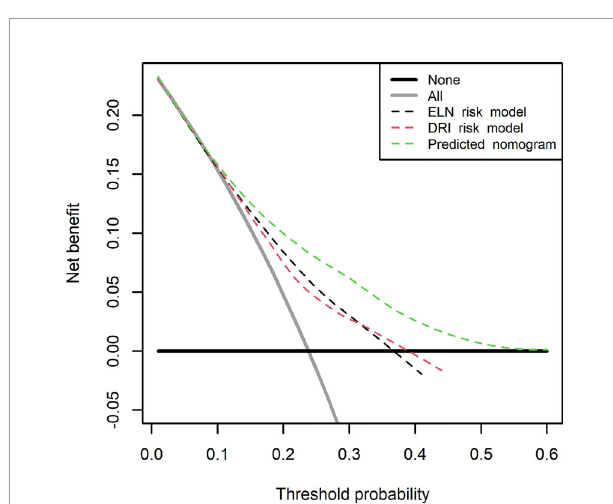
FIGURE 5 | Decision curve analysis for the predicted nomogram and the model with Disease Risk Index (DRI) and European LeukemiaNet (ELN)-2017 risk recommendation. The green line represents the predicted nomogram. The red and black line represents the predicted model with DRI and ELN- 2017 risk recommendation. Solid gray line indicates net bene fi t when all patients are considered as disease relapse after allogeneic hematopoietic stem cell transplantation (allo-HSCT). Bold black line indicates net bene fi t when all patients are not considered as developing disease relapse. The predicted nomogram showed the highest net bene fi t when threshold is higher than